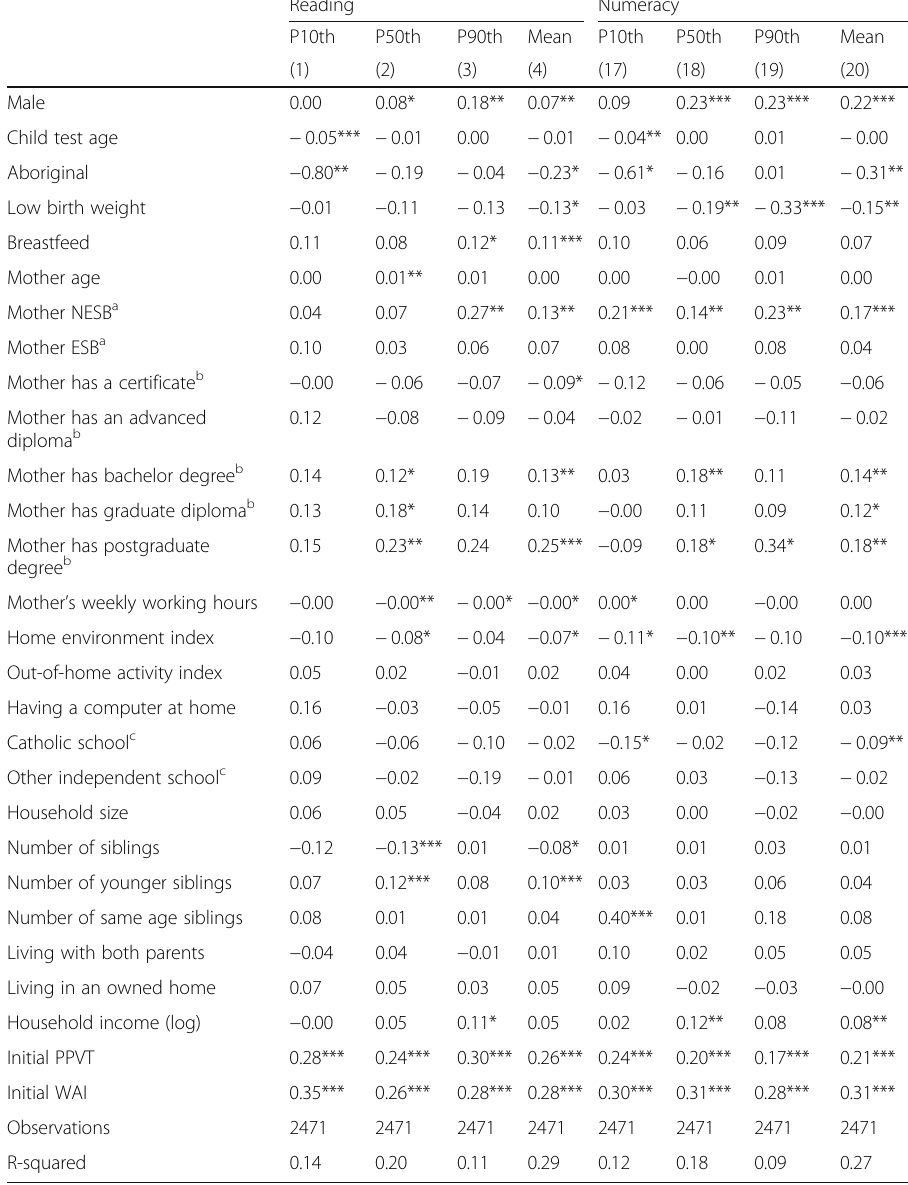
Table 9 Full regression results at selected percentiles and at mean — grade